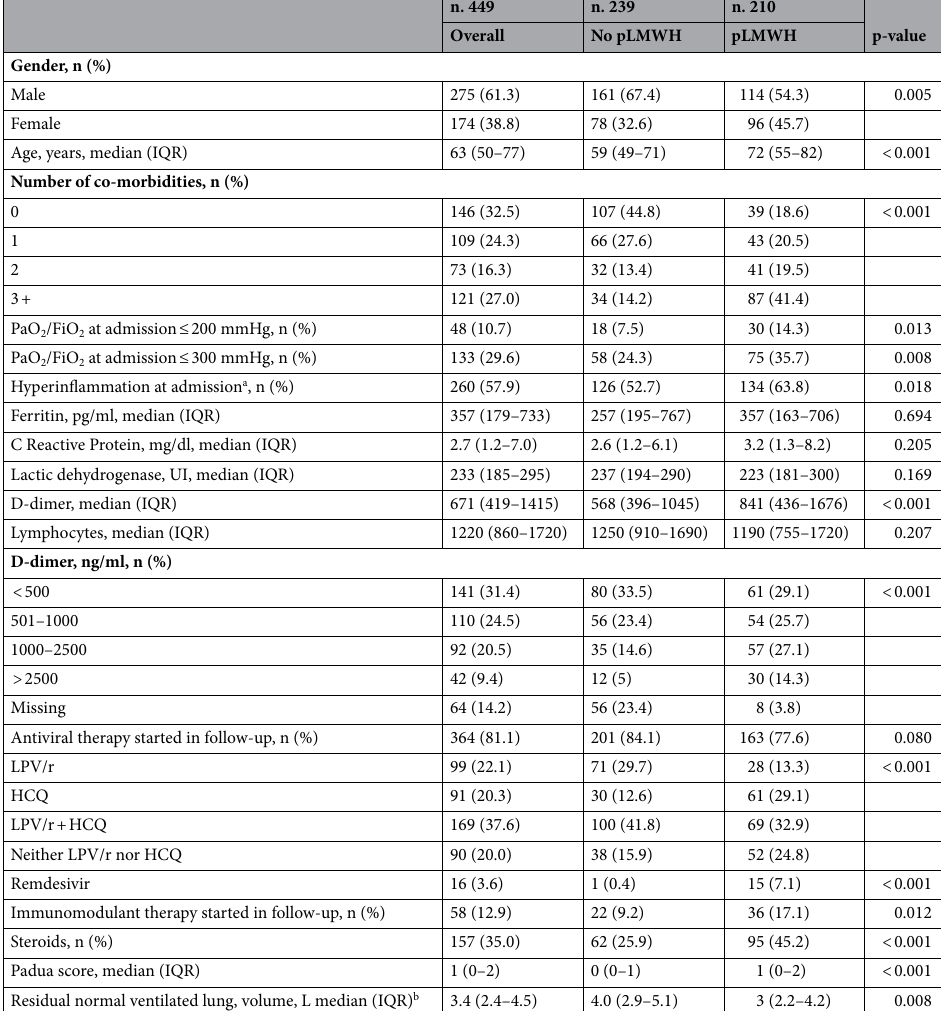
Table 1. General characteristics of study population. pLMWH prophylactic dose of low molecular weight heparin, IQR inter quartile range, COPD chronic obstructive pulmonary diseases, LPV/r lopinavir/ritonavir, HCQ hydroxychloroquine. a Defined by the presence of at least two of the following criteria: (a) blood lymphocytes < 1000/mmc; (b) ferritin > 500 ng/mL; (c) LDH > 300 U/L; (d) D-dimers > 1000 ng/mL; (e) C-reactive protein > 3 mg/dL. b Available for 130